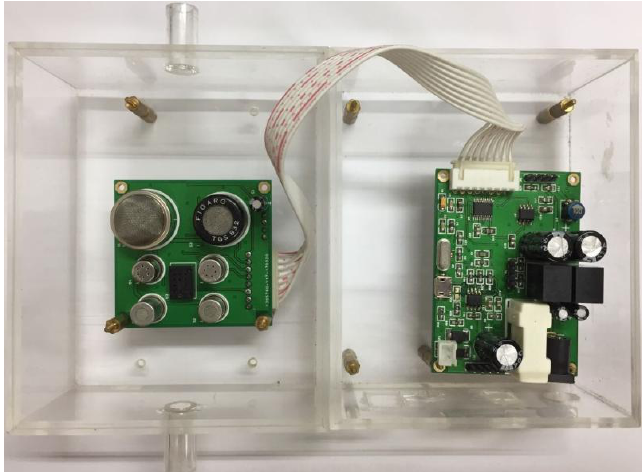
Figure 2. MOS-based E-nose prototype.